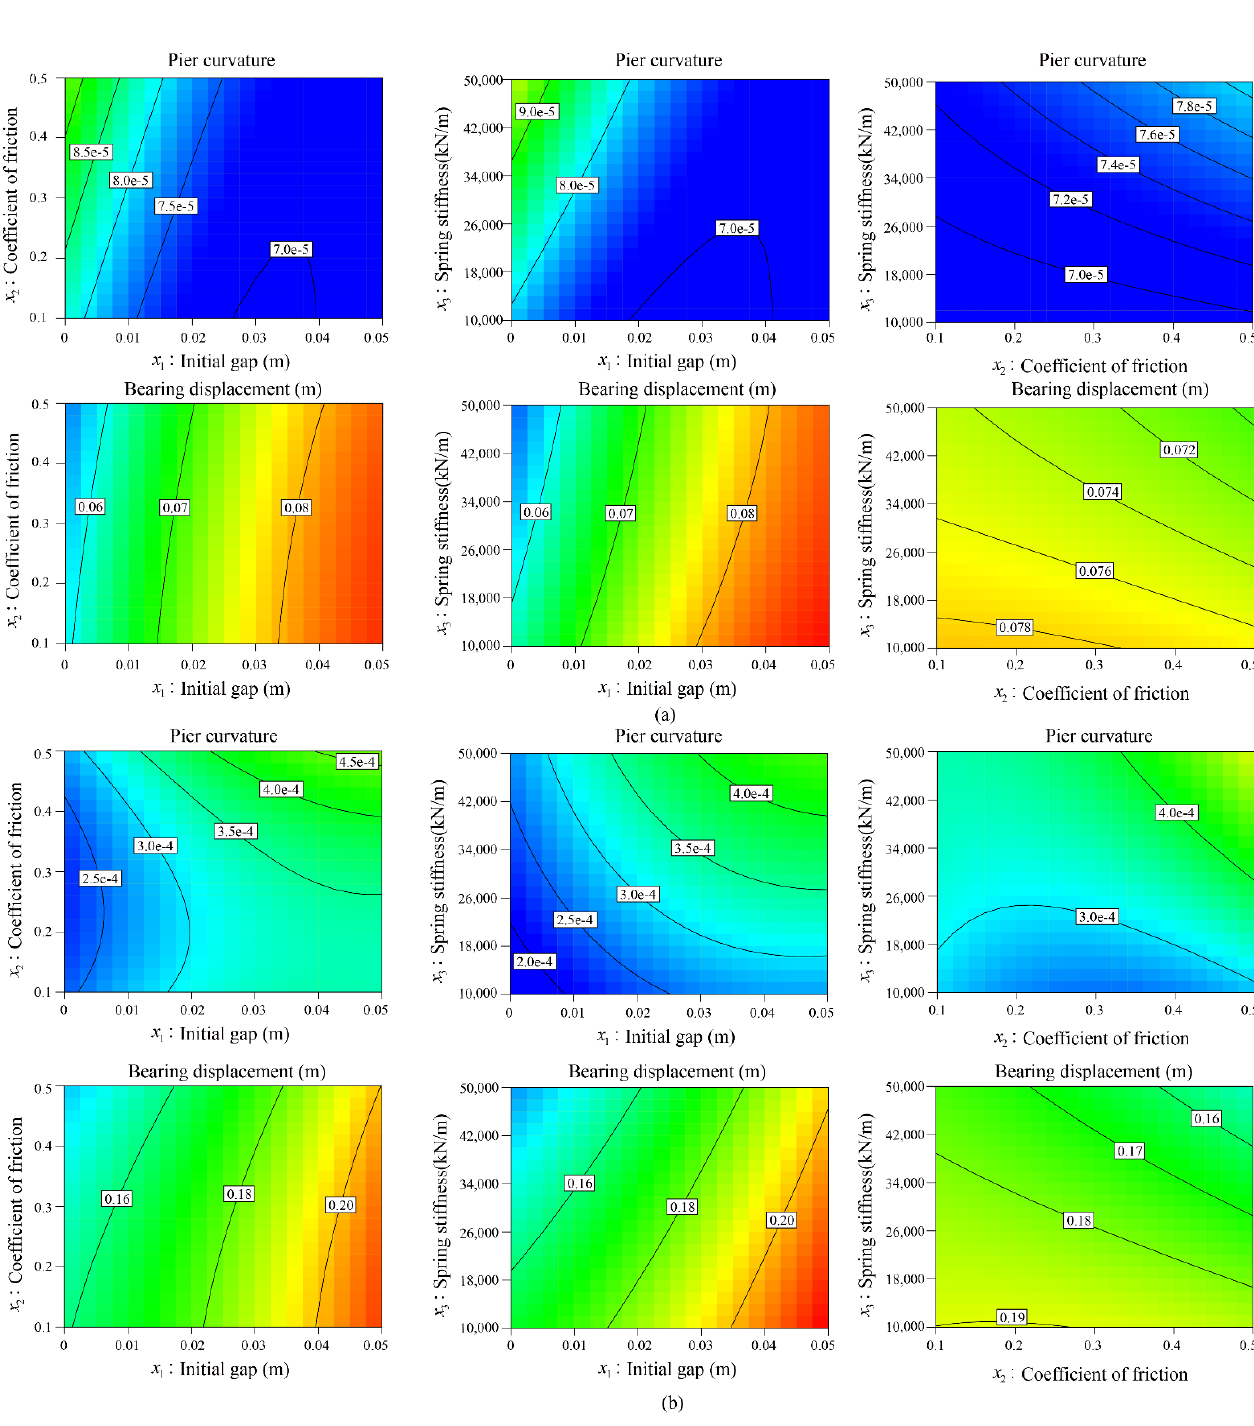
Figure 10. Contour maps of maximum pier curvature and bearing displacement with respect to the variables of initial gap ( x 21 ), coefficient of friction ( x 2 ), and spring stiffness ( x 3 ) of LFD: ( a ) wave 1 and ( b ) wave 7 in Table